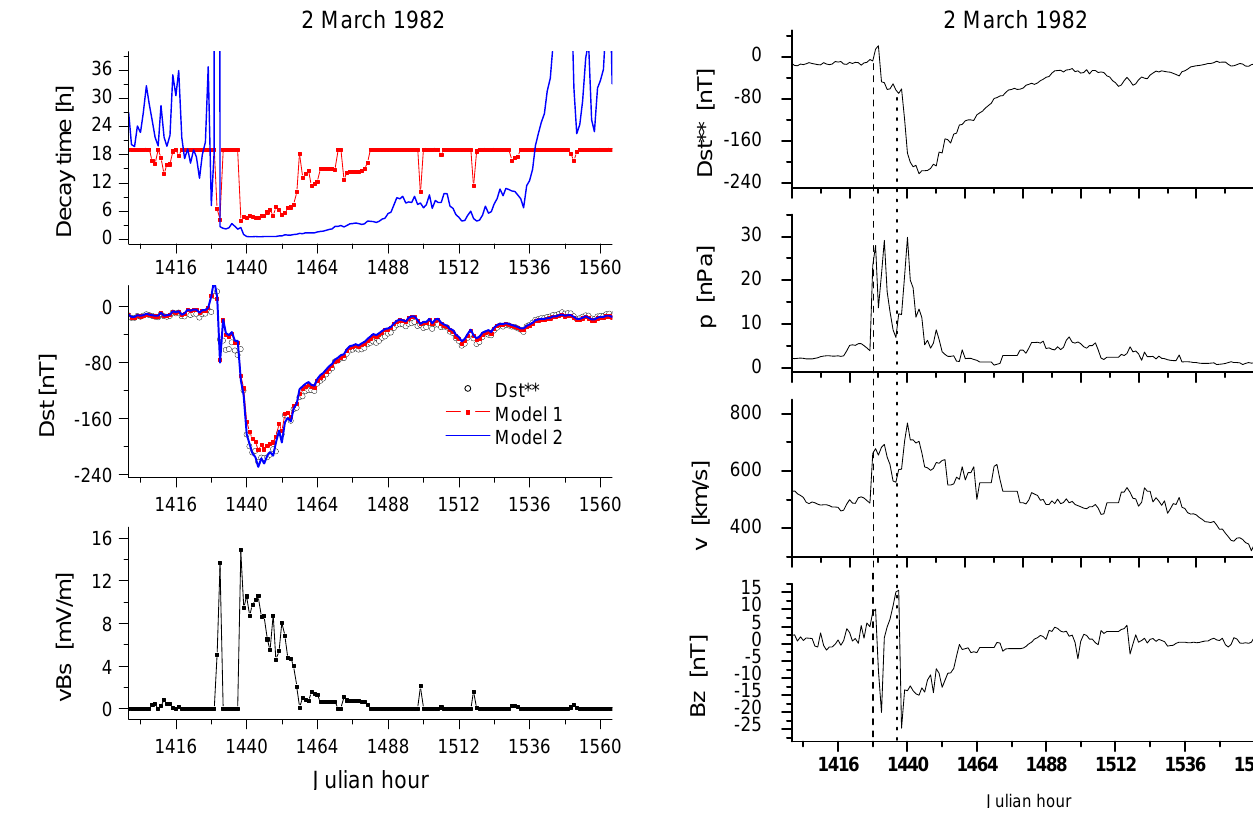
Fig. 4. Event: 1–6 March 1982. Same as that in Fig. 2 except for the period, between 1416 and 1560 Julian Hours on March of 1982. Fig. 5. Same as that in Fig. 3 except for the event of 1–6 March 1982. From top to bottom, the behavior of the pressure corrected D st index and the interplanetary parameters as dynamic pressure, solar wind speed and the electric field vB S